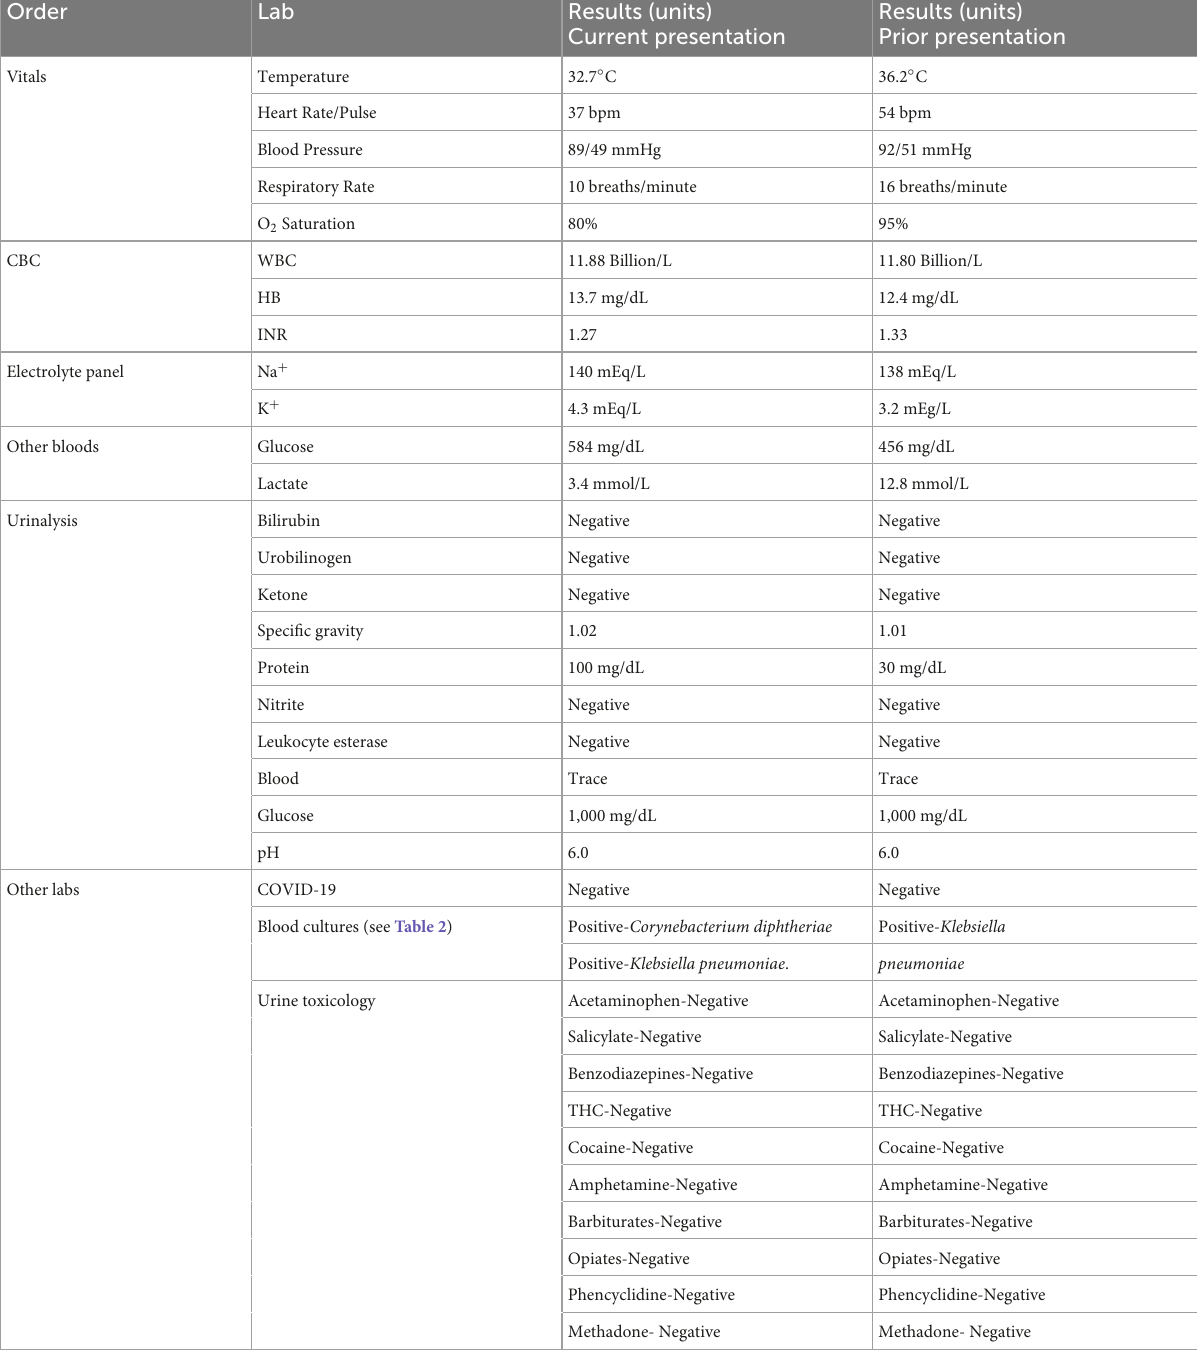
TABLE 1 Summary of vital signs and laboratory findings during current and prior presentation.